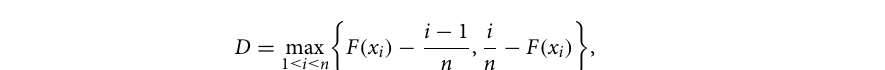
Figure 2. Population trends in different